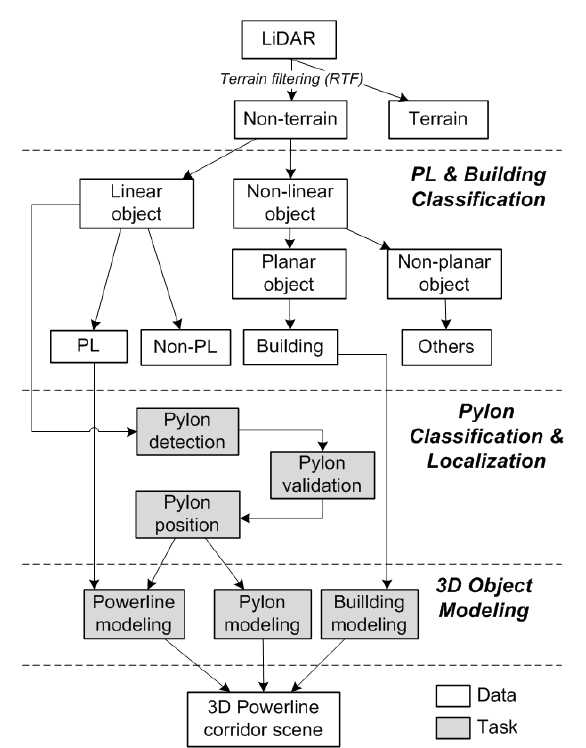
Figure 1. Overall workflow for 3D reconstruction of objects including PL, pylon, and building in the PL corridor